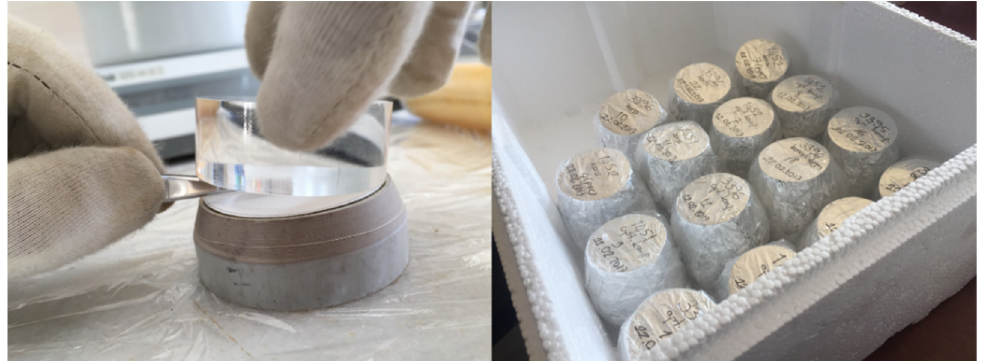
Figure 6. Insertion of filter paper and protection of samples from evaporation.